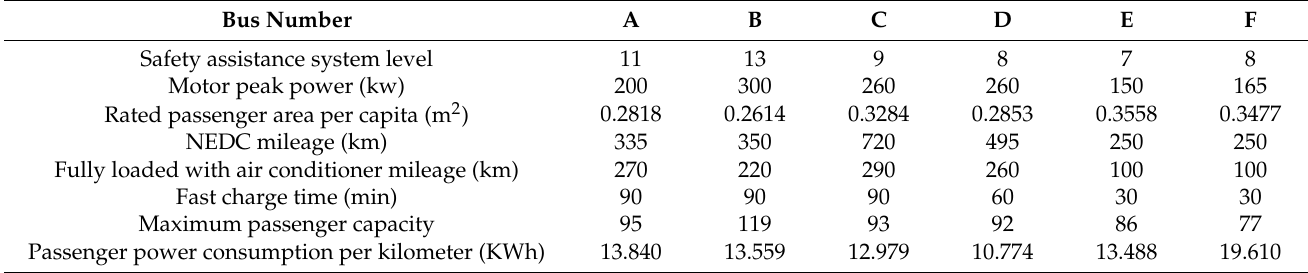
Table 1. Related indicators of 6 chosen electric